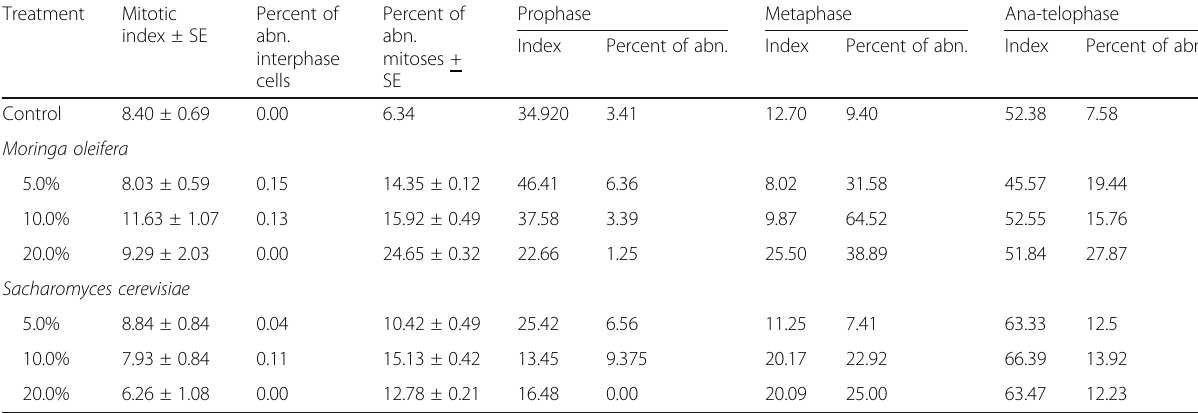
Table 1 Mitotic and phase indexes and percentages of abnormal mitosis and abnormality in each mitotic phase in Allium cepa root tip meristems, after 3 h treatment with Moringa oleifera and Sacharomyces cerevisiae extracts Treatment Mitotic Percent of Prophase Metaphase Percent of index ± SE abn. abn. interphase cells